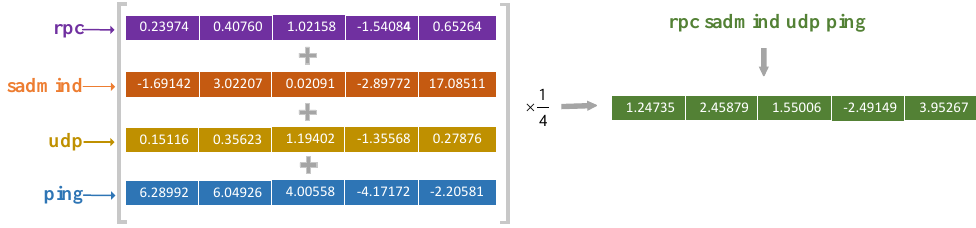
Figure 3. An example of an alert